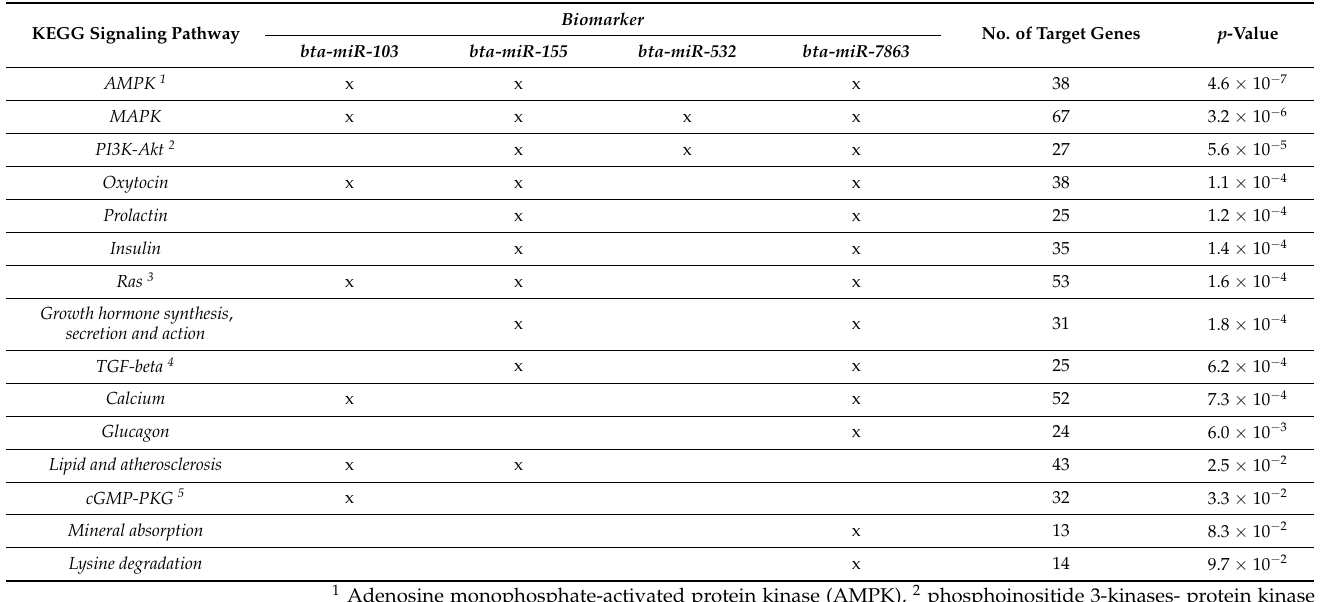
Table 1. KEGG pathways that are associated with milk production and metabolism and that are predicted to be regulated by milk miRNAs with differential levels across production systems.